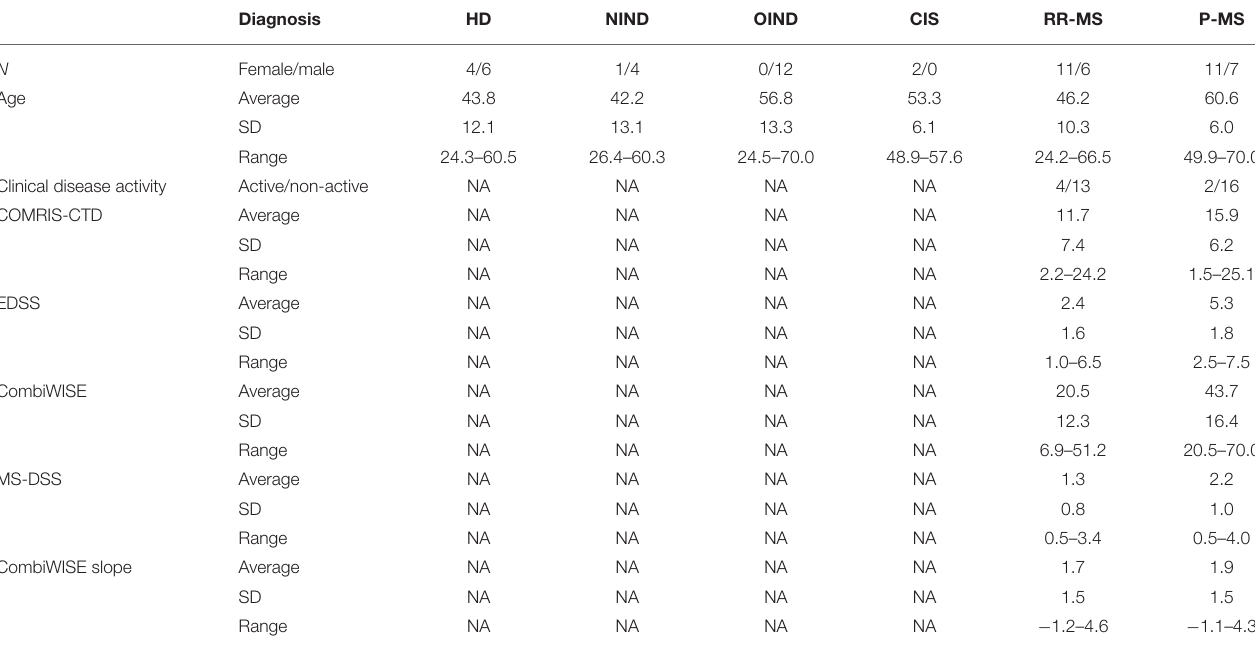
TABLE 1 | Subjects’ demographics data based on their disease